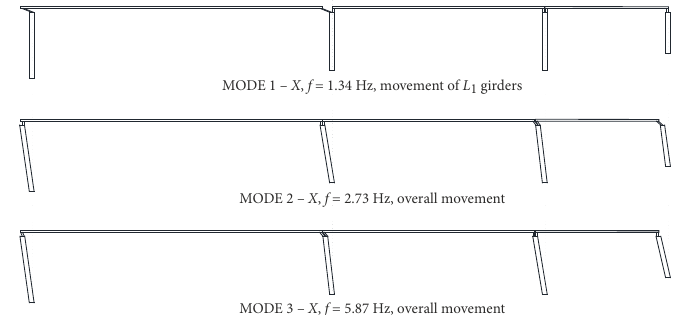
SurveyFigure 8. Obtained mode shapes in X direction in the first Ambient Vibration Survey